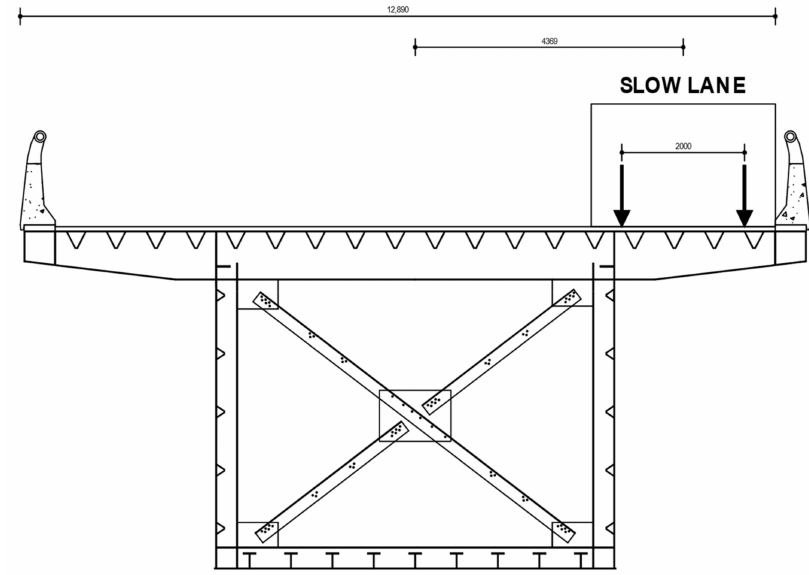
Figure 15. Slow lane—Cross section of the case study.